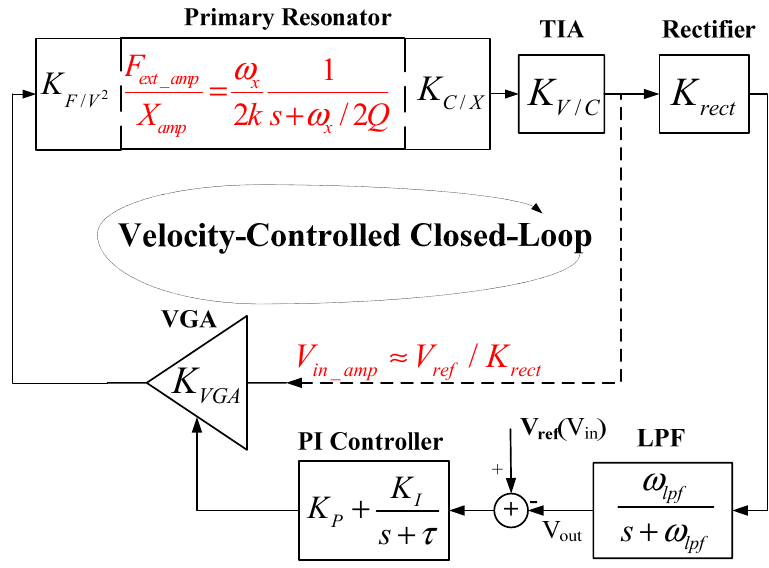
Figure 2. 3rd order linear system model of the velocity-controlled